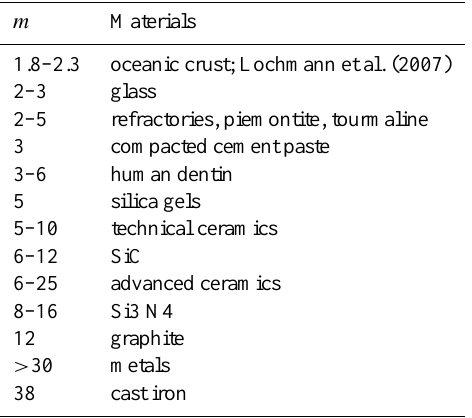
Table 1. Typical values of the Weibull modulus m